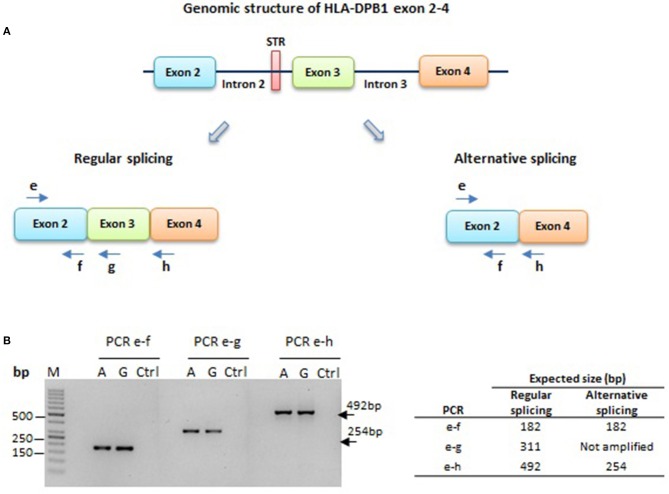
HLA-DPB1 exon 2–4 splicing in HLA-DPB1 rs9277534-G/A haplotypes. (A) A short tandem repeat (STR) of 4 or 10-16 GGAA repeats associated with the rs9277534-G or -A SNP, respectively, is located 44 bp upstream of exon 3 (Table 5) (28). The longer STR variant might facilitate splicing of exon 3, giving rise to an alternative splice product joining exons 2 and 4, which would not produce a functional HLA-DP protein. To test this hypothesis, PCR amplicons were generated using a common forward primer “e” in exon 2, and 3 reverse primers “f”, “g” and “h” in exon 2, 3 and 4, respectively. (B) RT-PCR on RNA from 6 BLCL carrying the rs9277534-G or -A linked haplotypes 1 and 6, respectively (Table 4). Shown is agarose gel electrophoresis obtained with primer pairs e-f, e-g and e-h on one representative BLCL for each haplotype (A or G). All three PCR products of 182 bp, 311 bp and 492 bp respectively were produced, while the 254 bp expected for alternative splicing was absent in both haplotypes. M; Molecular weight marker; Ctrl; no template control.